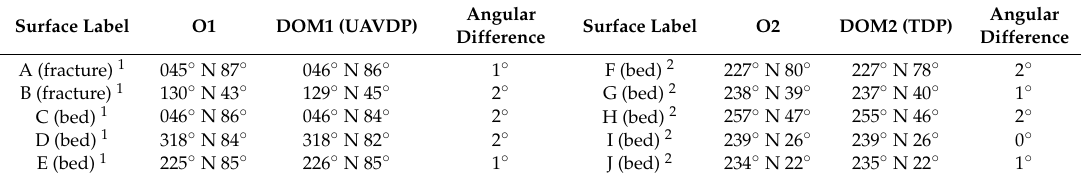
Table 6. Comparison between field manual attitude measures (O1 and O2) and DOM digital attitude measures (DOM1 and DOM2). The angular difference represents the solid angle between the attitude vectors.